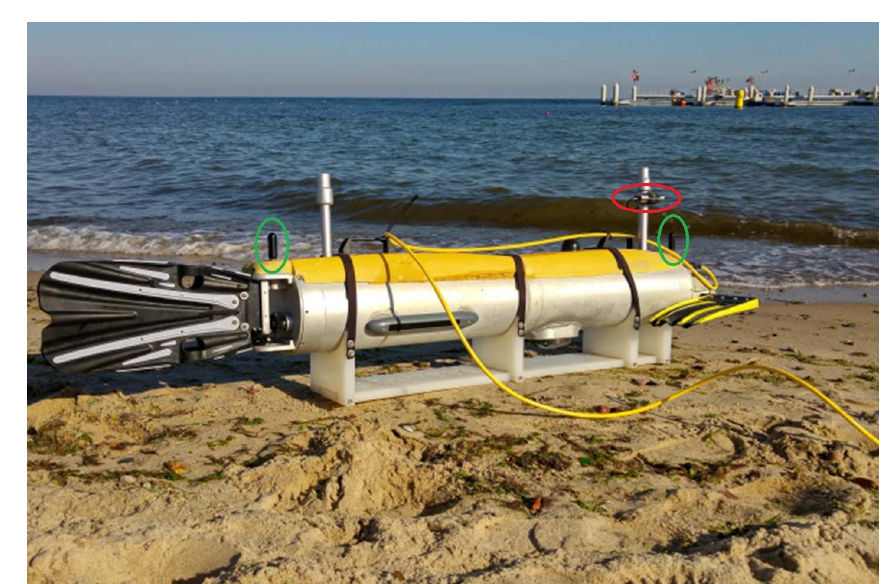
Figure 3. The Biomimetic Underwater Vehicle no. 2 (BUV2) before launching (the video camera is marked by a red circle and the hydrophones are marked by a green